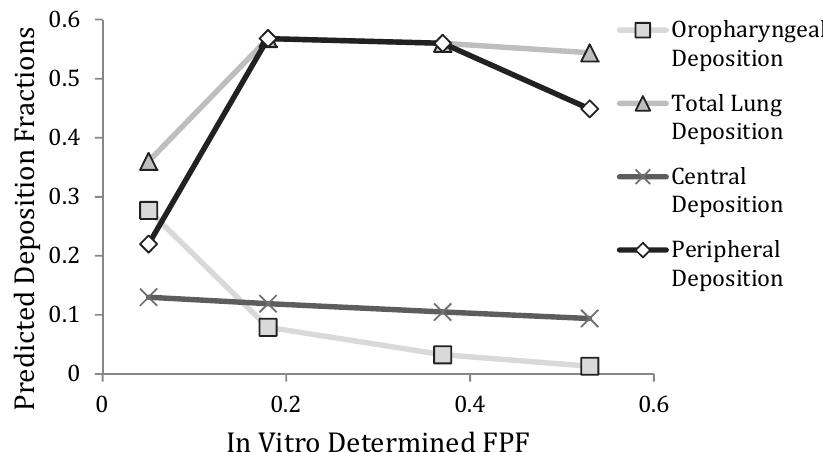
Fig. 5 Relationships between the in vitro determined fine particle fractions and the in silico predicted deposition patterns using HFA 134a/ethanol pMDI